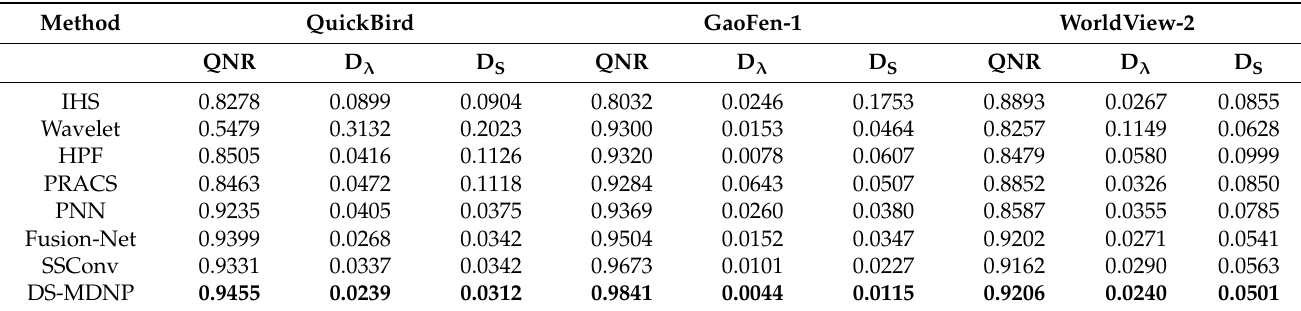
Table 8. Quantitative evaluation comparison of real data experiments on three datasets. The values in bold represent the best